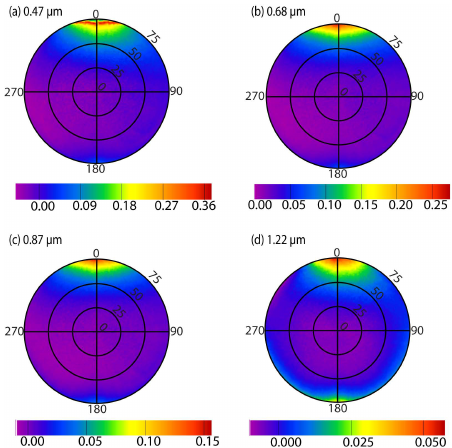
Fig. 6. Error of atmospheric correction over snow using the Lam- bertian approximation ( ρ − ρ Lamb ) for surface BRF, in visible and NIR